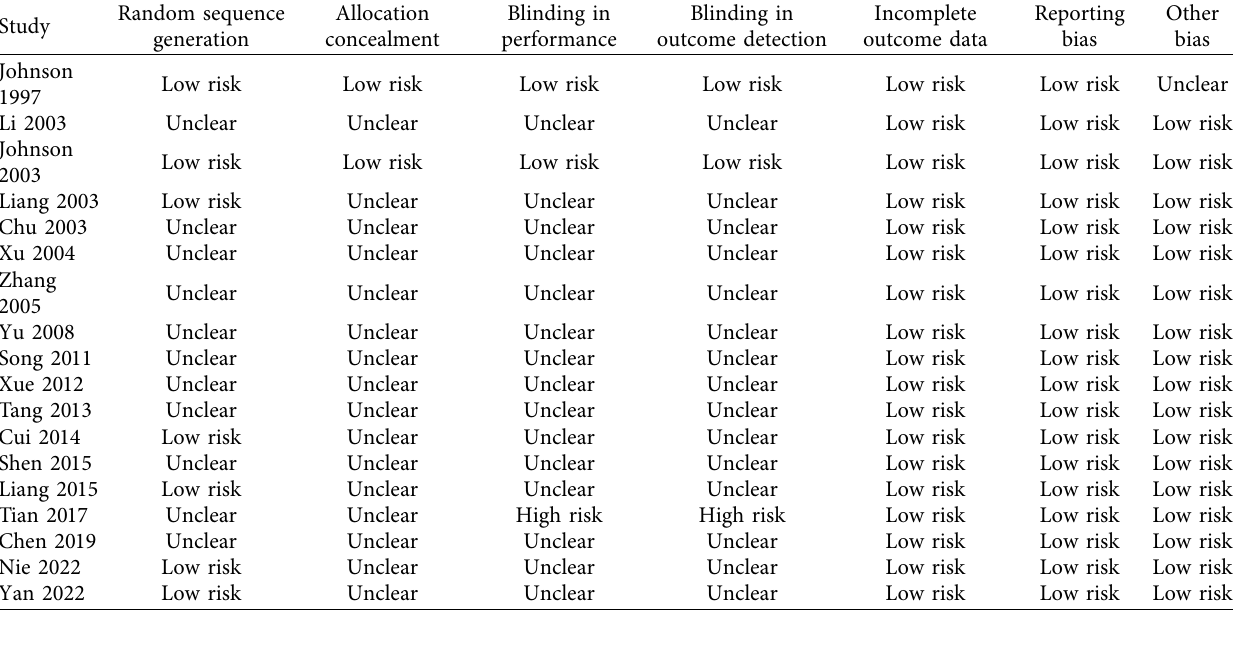
Table 2: Details of quality evaluation via the Cochrane’s risk of bias